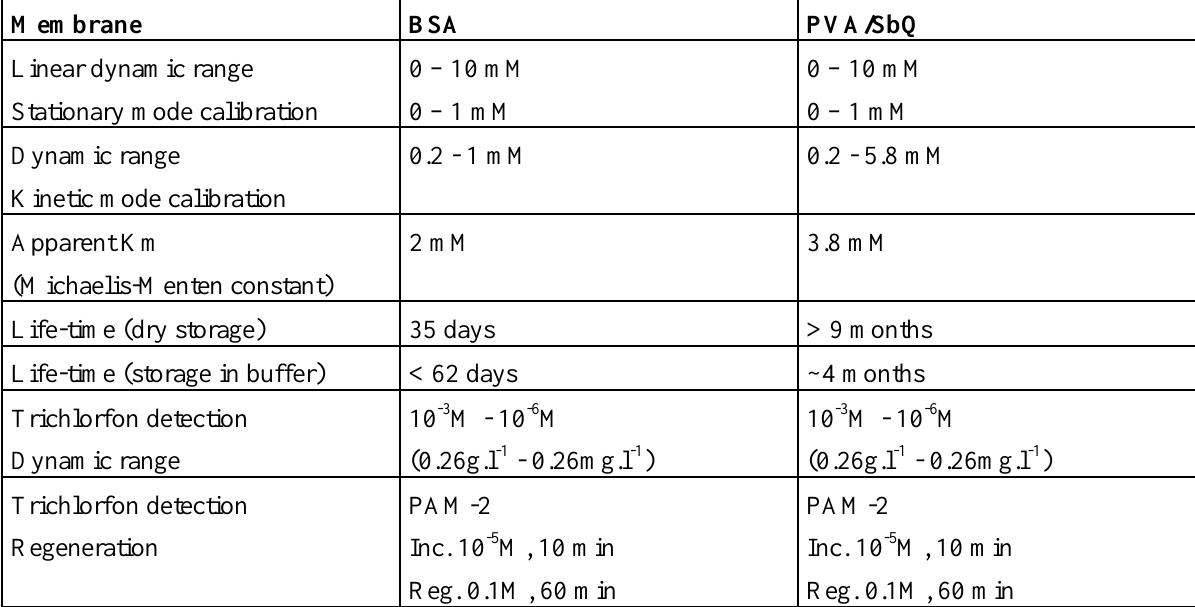
Figure 4. Recovery of the BSA-BuChE biosensor response after incubation by 0.1M of PAM-2b in a phosphate buffer after incubation for 10min at different concentration of trichlorfon. Table 3. Compared analytical features of BSA and PVA/SbQ